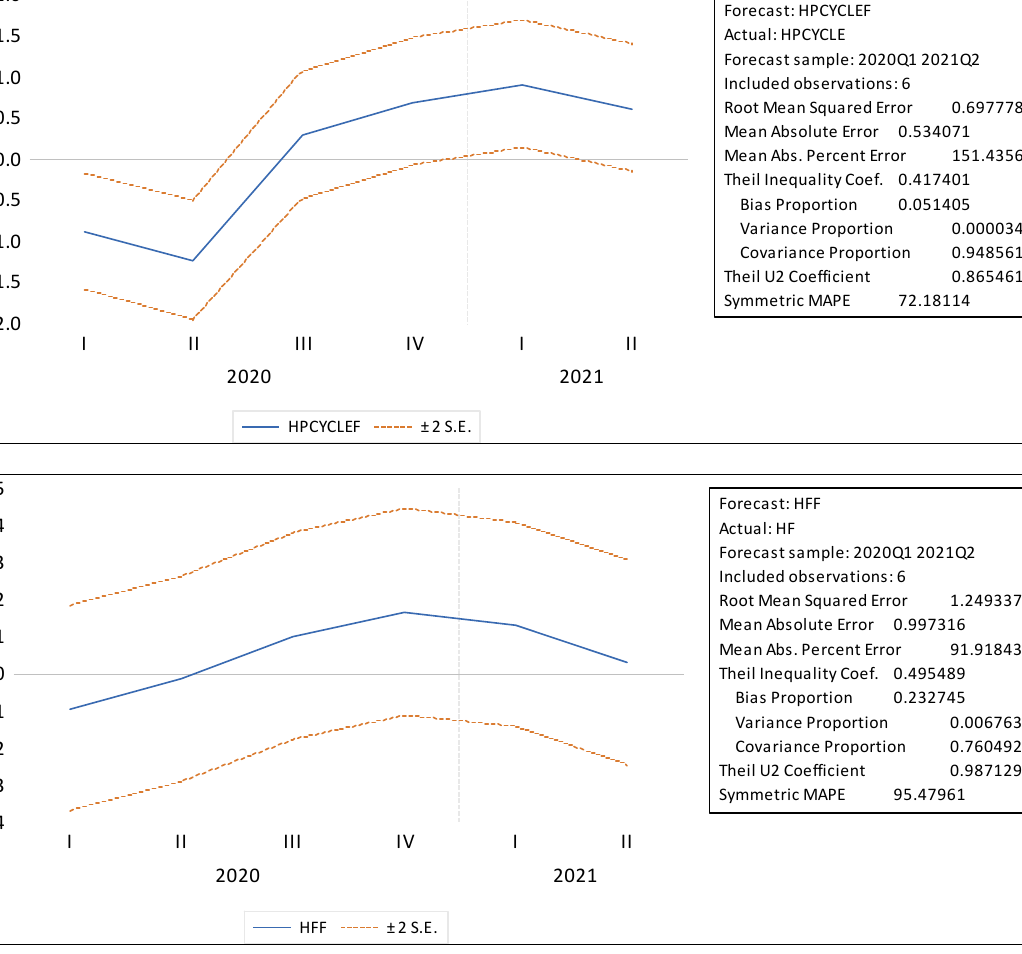
Figure 7. Dynamic forecasting of unemployment for both filters during the period 2020Q1–2021Q2.